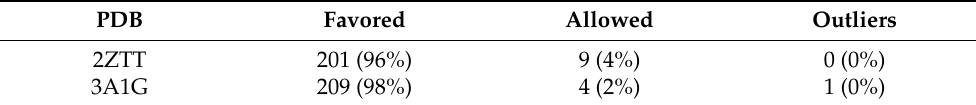
Table 1. Results of the Ramachandran plot analysis of 2ZTT and 3A1G.